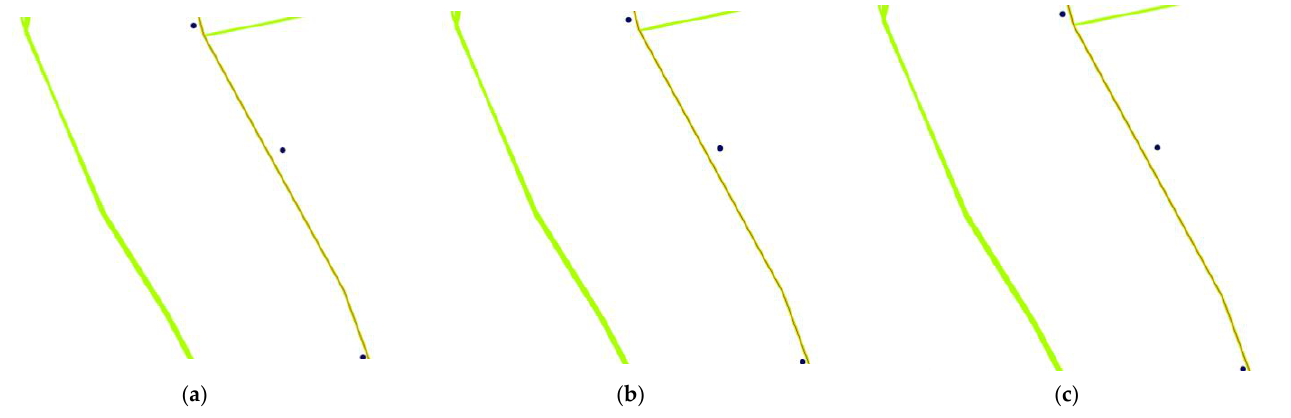
Figure 14. Visual comparison results of the algorithms under a single road topology. ( a ) ST-Matching algorithm. ( b ) SD-Matching algorithm. ( c ) The proposed